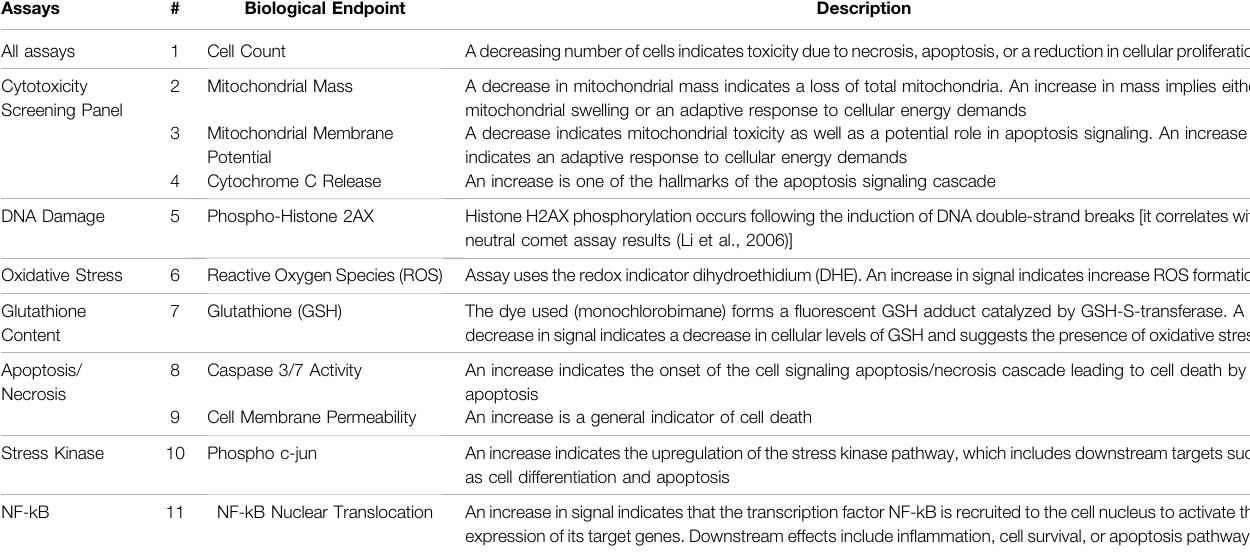
TABLE 1 | HCS endpoints description.